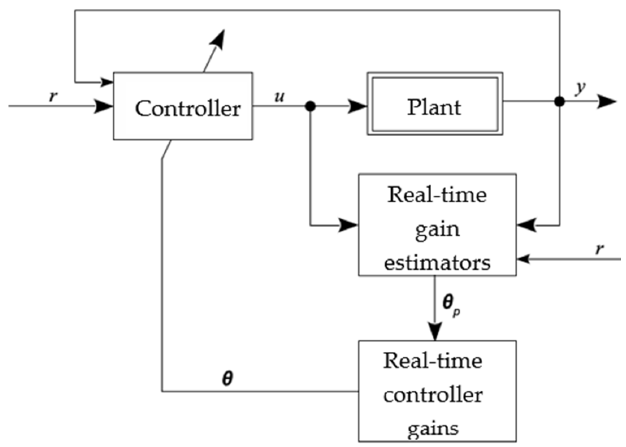
Figure 2. Direct adaptive controller.